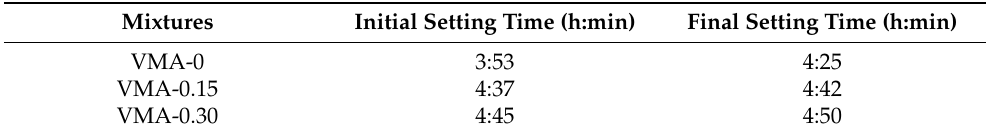
Table 4. Initial and final setting times.